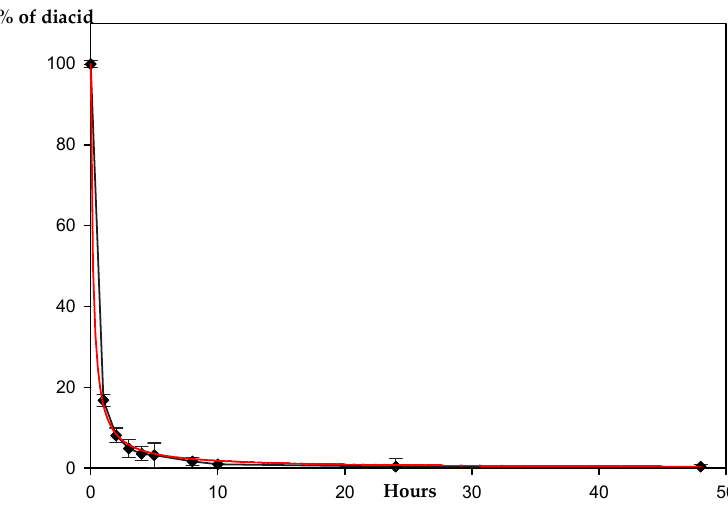
Figure 1. ω -Carboxyl oxo PA consumption in the enzymatic copolymerization reaction with 1,8-OD.